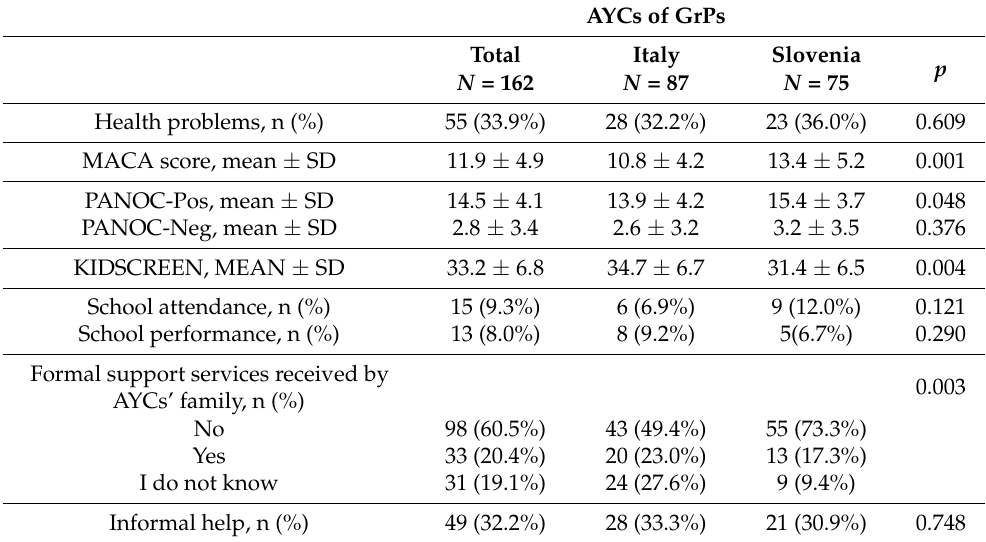
Table 2. Caregiving outcomes and support services received by AYCs of